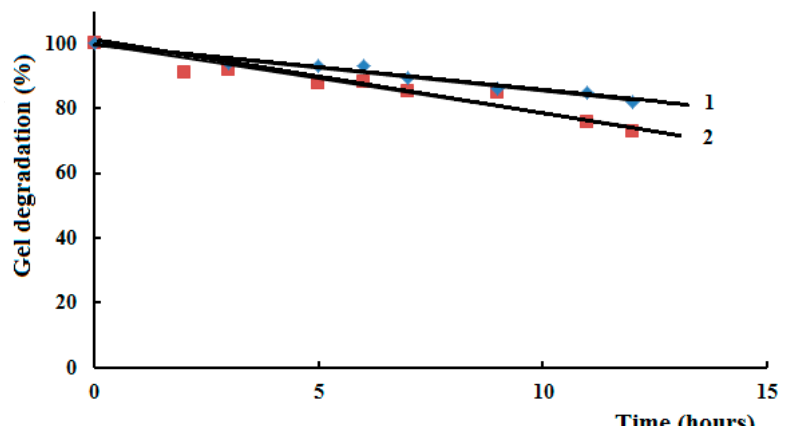
10 of 15 Figure 11. Weight loss of hydrochloride/apple pectin hydrogels: 1—distilled water; sodium phos- phate buffers with different pH: 2— рН = 6.4; 3— рН = 5.8; 4— рН = 7.4; 5— рН = 8.0. Data are ex- pressed as mean ± SD; n = 3. 2.5. Enzymatic Degradation Since the use of the developed hydrogels involves their contact with the living tis- sues in a human body with exposure to enzymes of various natures, an experiment was conducted to identify the effect of the hyaluronidase enzyme on the hydrogel and its degradation. Hyaluronidase is a specific enzyme that breaks hyaluronic acid down. At the same time, it was shown [26,27] that this enzyme successfully hydrolyzes chitosan in acidic solutions on the surface of films and reduces the particle size of polyelectrolyte